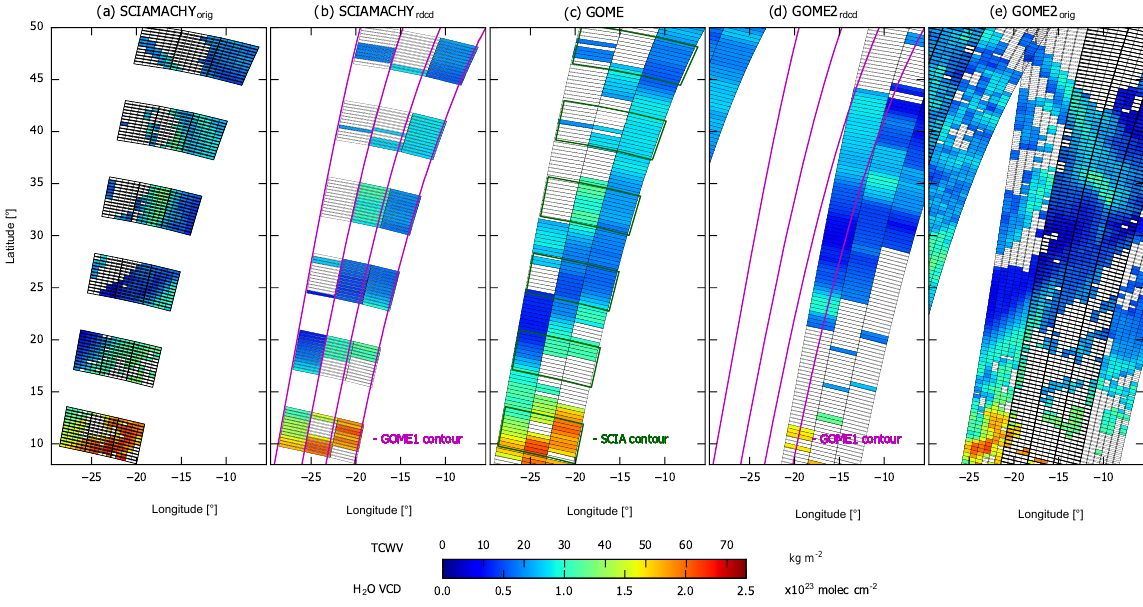
Figure 2. TCWV from the different satellite instruments in original and reduced resolution on 1st of June 2009. White pixels are masked by the cloud flag as described in Sect. 3.1. (a) SCIAMACHY pixels in original resolution. The grouping into GOME-like pixels is indicated by thick black lines. Gaps along the orbit are caused by observations in limb mode. (b) SCIAMACHY pixels in reduced resolution. In magenta, the orbital pattern of GOME is displayed for comparison with (c) . (c) GOME pixels. In green, the SCIAMACHY states are indicated for better comparison with (a) and (b) . The time shift between SCIAMACHY and GOME is 29min. (d) GOME-2 pixels in reduced resolution. In magenta, the orbital pattern of GOME is displayed for comparison with (c) . The GOME-2 orbital patterns are shifted compared to GOME and SCIAMACHY. (e) GOME-2 pixels in original resolution and full GOME-2 swath. The grouping into GOME-like pixels is indicated by thick black